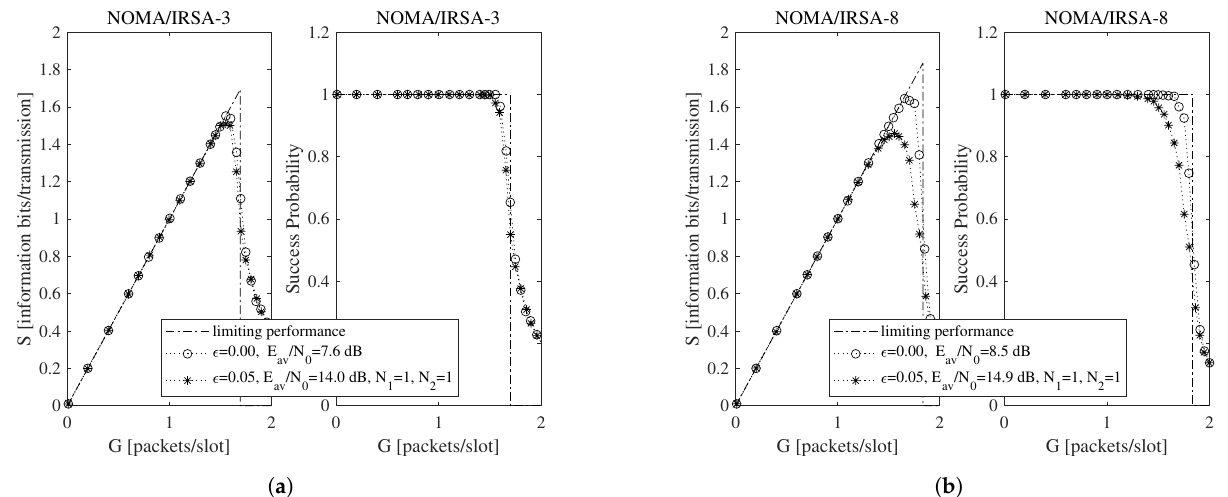
Figure 4. Throughput and success probability as a function of the channel load for K = 1000, L = 3, and R = 1 information bits per symbol: ( a ) NOMA/IRSA-3, ( b ) NOMA/IRSA-8.